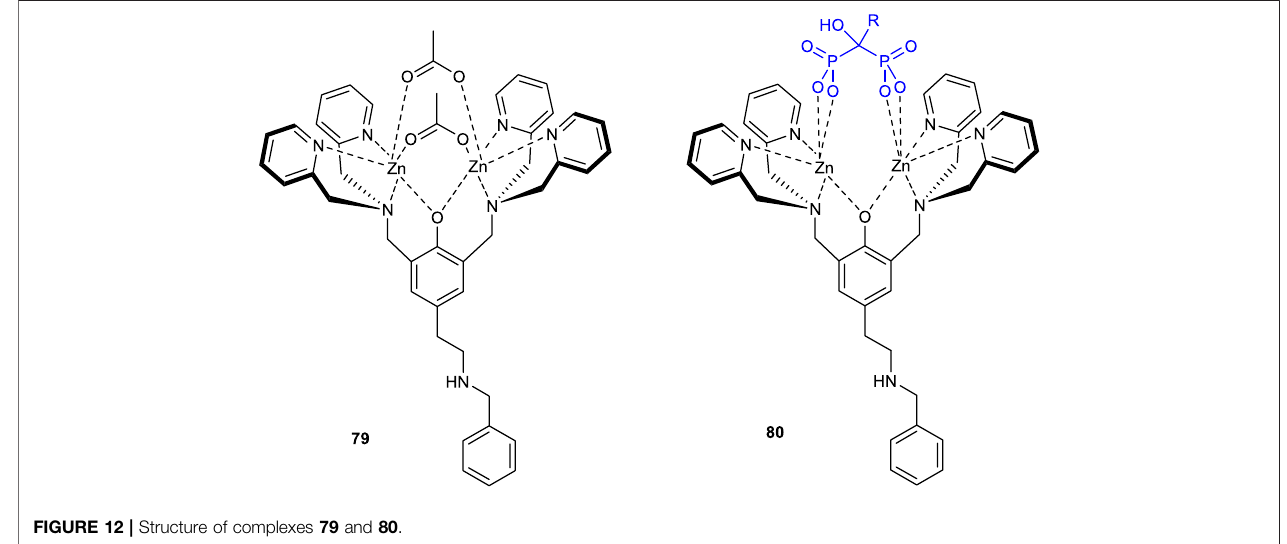
FIGURE 12 | Structure of complexes 79 and 80 .